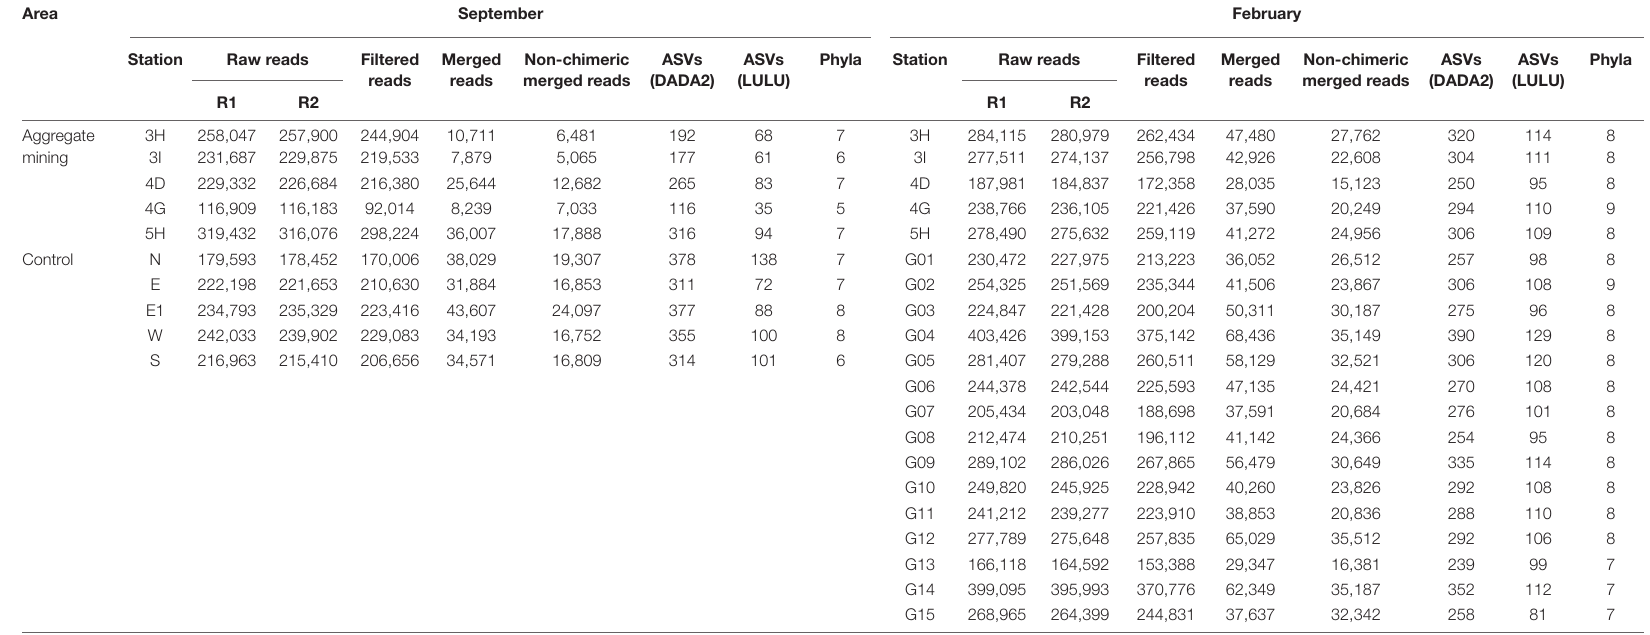
TABLE 5 | Summary of taxonomic assignment of phytoplankton reads in Korean coastal